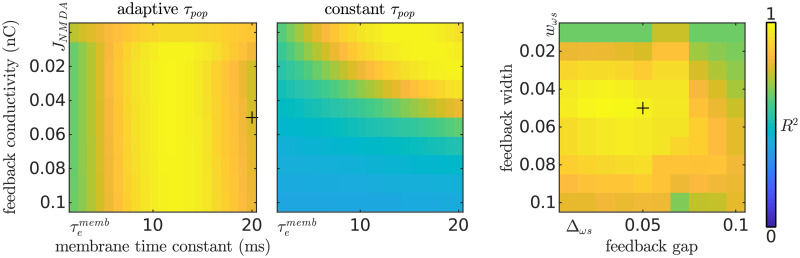
Experimental fit in relation to the FM-feedback spectral model parametrisation.Heatmaps show the explained variance of the experimental data R2. Unless stated otherwise, parameters not varied in the matrices correspond to the values listed in Table 1. The two leftmost plots show the dependence of R2 with the conductivity of the feedback connections and the dynamics of the excitatory population time constants. Different values of the nominal population’s time constant were used to illustrate that the dynamic effect (rather than the resulting shorter time constant) is crucial to explain the experimental results; however, during the parameter tuning the temporal constant was constrained to τmemb = 20 ms based on physiological observations [44]. The rightmost plot shows the dependence of R2 on the width and reach (wωs and Δωs, respectively; see Methods) of the feedback connections. Black crosses in the parameter space signal the final parametrisation.